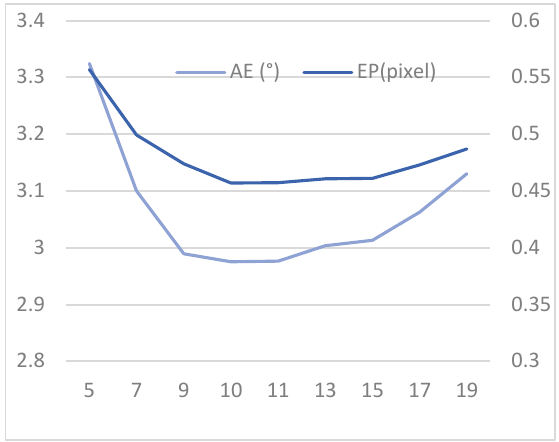
Figure 7. Error related to patch size.